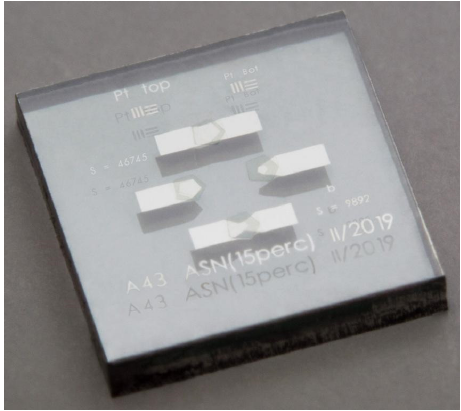
Figure 1. Sensory element based on the “Al/(Al,Sc)N/Mo/(001) diamond” multilayer piezoelectric structure.